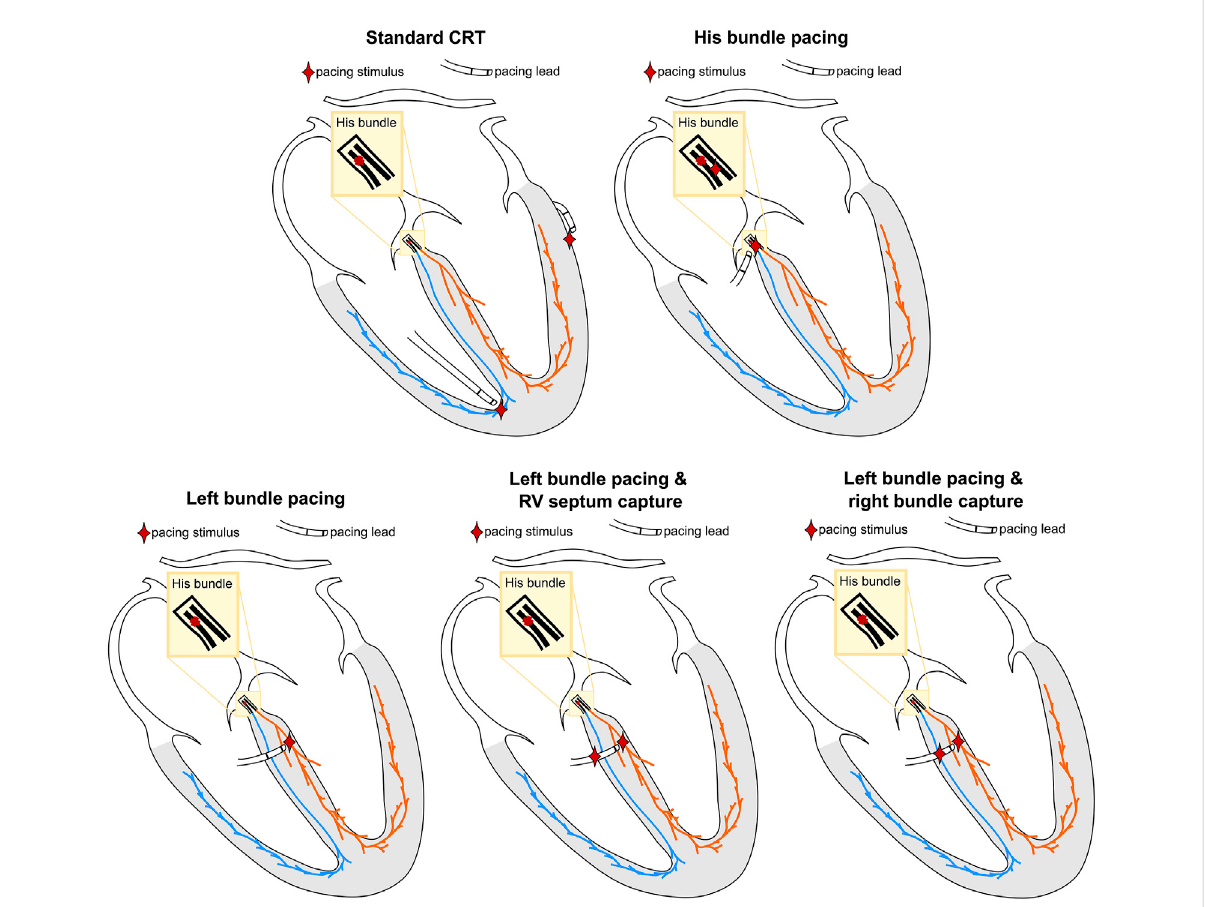
FIGURE 2 Schematic representation of the simulated pacing locations. The location of the pacing stimuli is represented by the red star. The colors of the different regions correspond to Figure